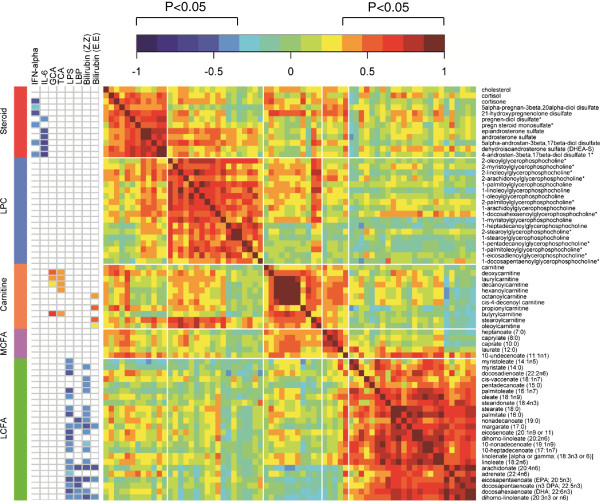
Correlation matrix reveals relationships between clusters of lipids and markers of inflammation and hepatic function. The Pearson correlation matrix was constructed in R using the heatmap.2 function. Significant correlations had a −0.35> r >0.35, p<0.05, and FDR<10% (Additional file 5). Red and blue indicate positive and negative correlations, respectively (see Color Key).